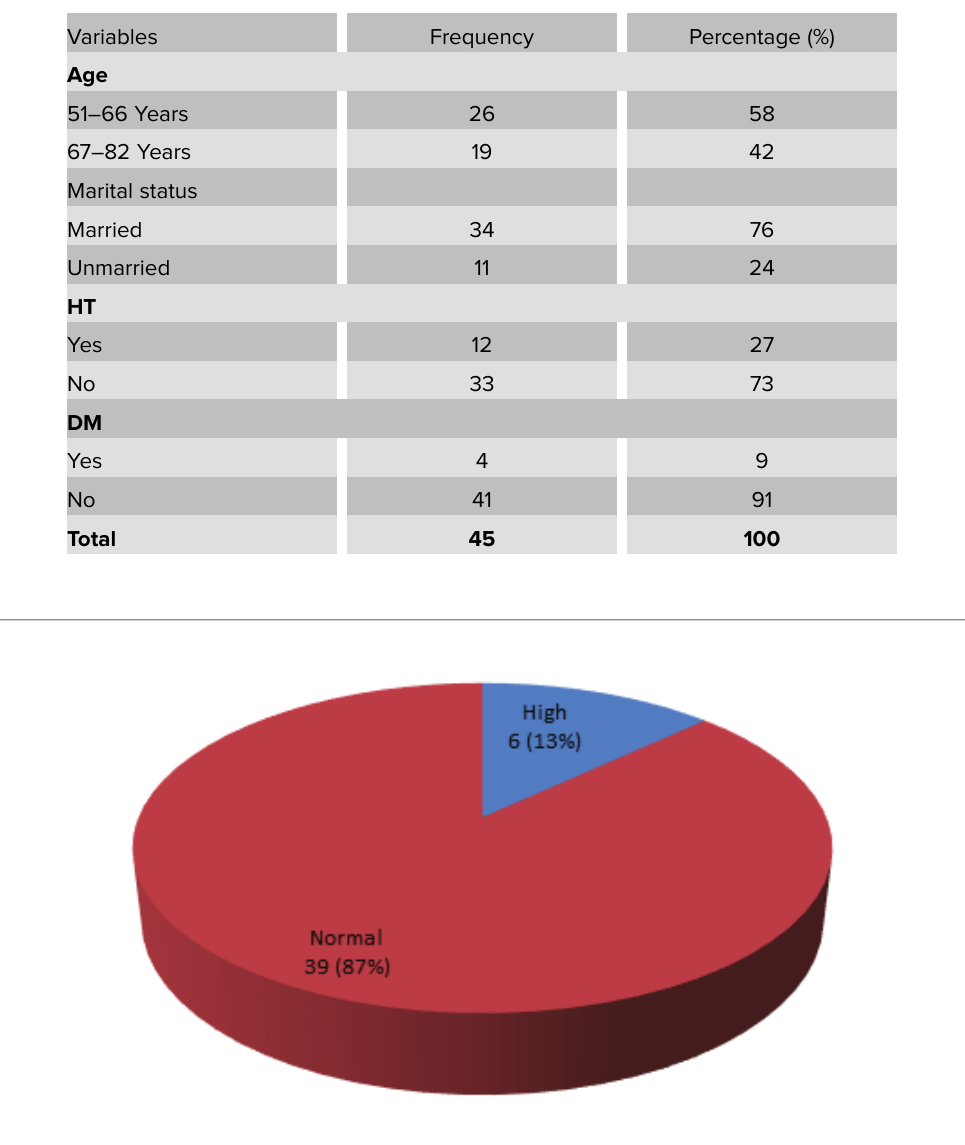
Table 1: Demographic and clinical data in the population study.